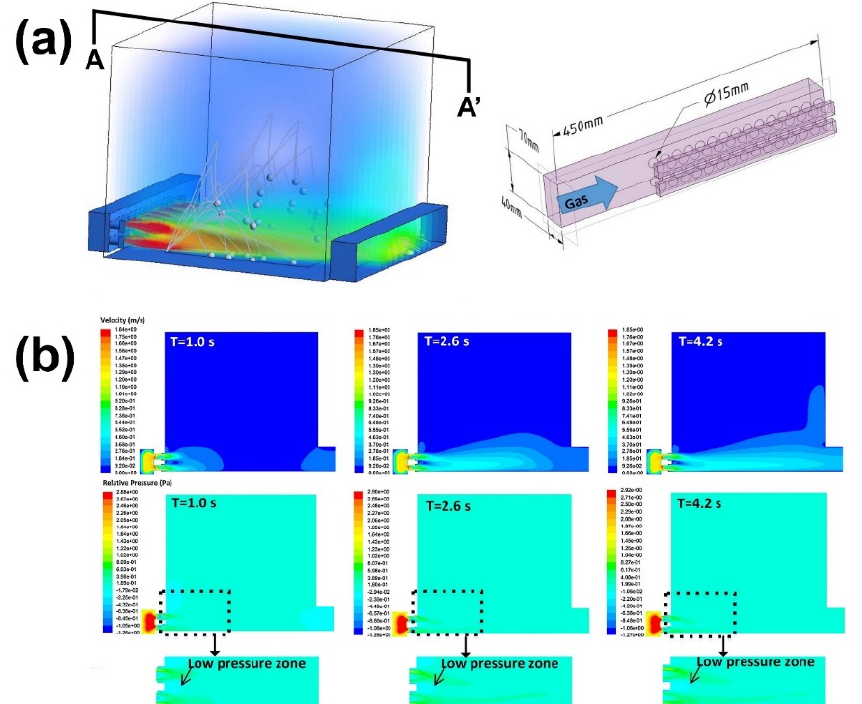
Figure 27. CAD model of counter-Coanda effect in L-PBF build chamber: (a) the counter-Coanda effect design that employs another row of nozzles directly under the primary nozzles; (b) A-A’ plane: transient velocity and pressure field. (Reprinted with permission from Ref. [137]. Copyright 2020 Elsevier B.V.).